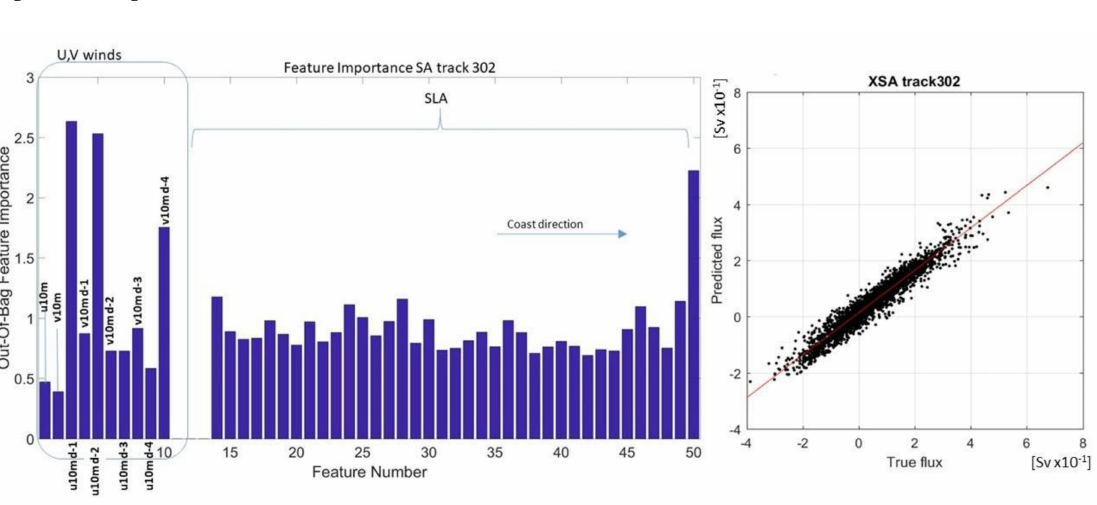
Figure 2. Example of the feature importance analysis in the random forest algorithm (left panel); and application to simulated data (i.e., Volume flux is shown in Sverdrup, 1 Sv = 10 6 m 3 / s) for Saral / Altika track